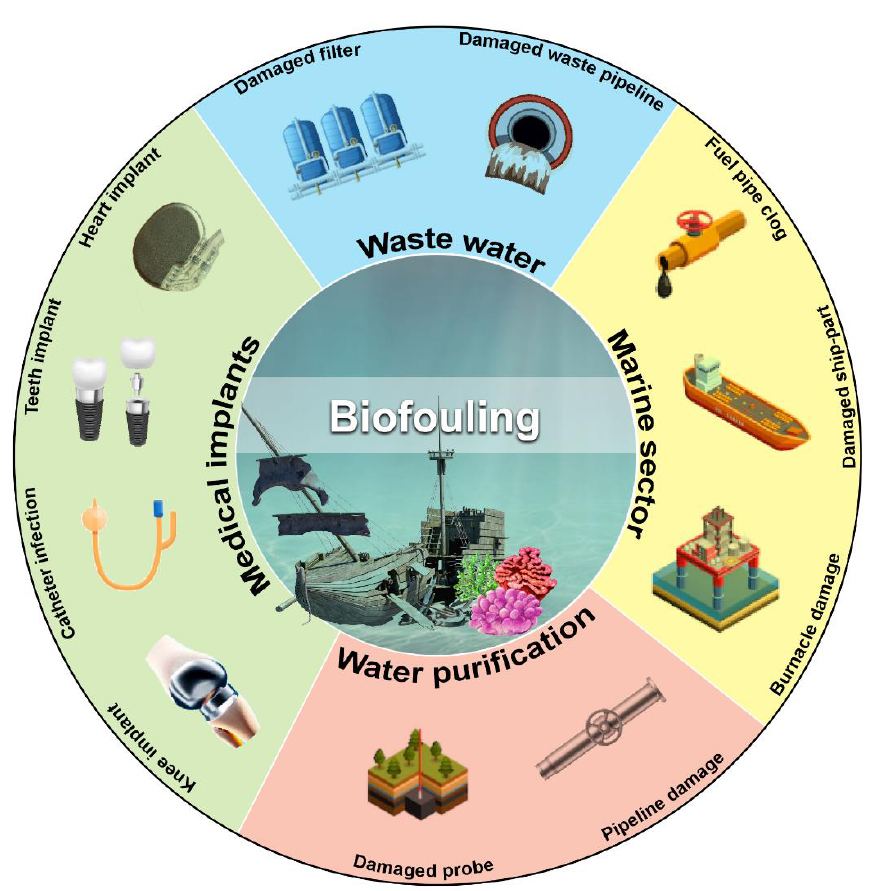
Figure 1. Schematic overview of the harmful impact of biofilm-mediated biofouling. Various sectors affected by biofouling are shown with representative pictures of the damaged part of affected objects. (Figure credit Freepik.com, accessed on 27 October 2022).